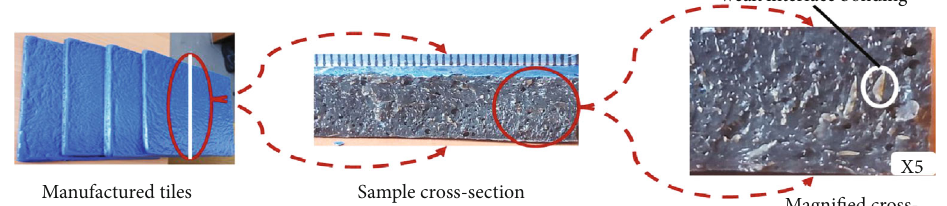
Figure 4: Sample cross-sectional area.